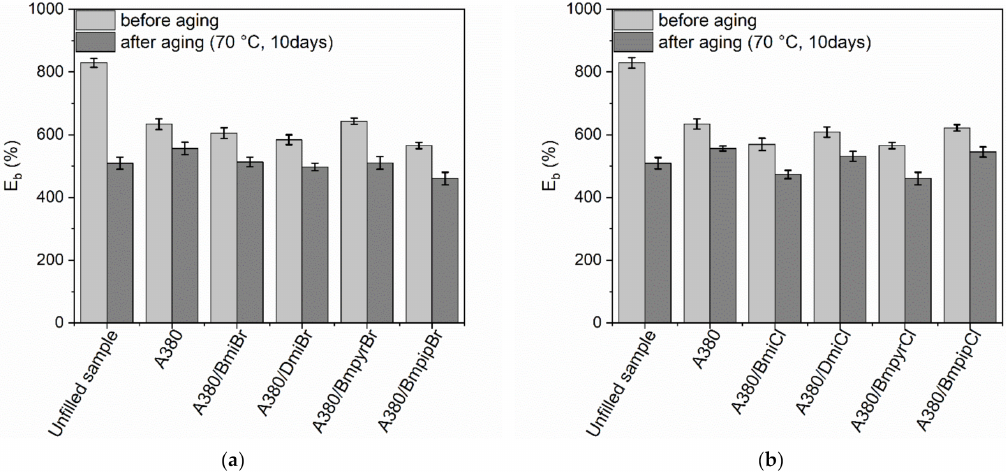
Figure 7. Influence of thermo-oxidative aging on the elongation at break (E b ) of the silica-filled NR vulcanizates containing ILs with: ( a ) bromide anion; ( b ) chloride anion.